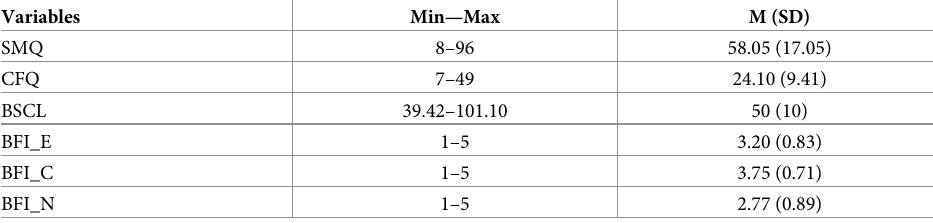
Table 2. Descriptive statistics of questionnaire scores.